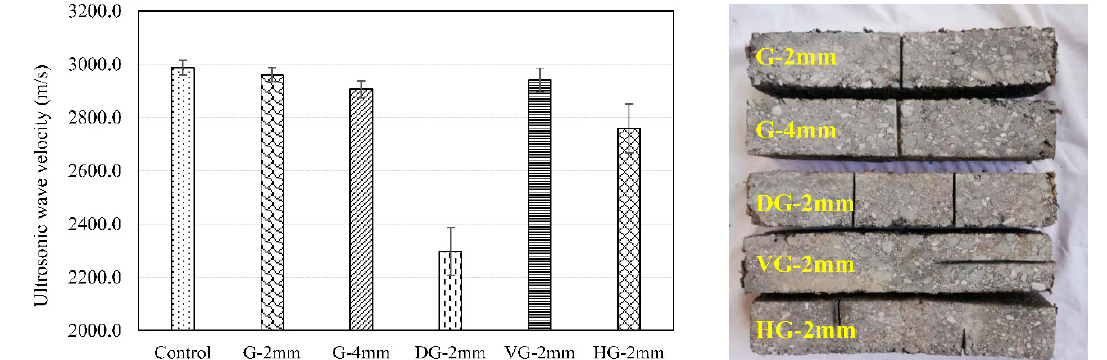
Figure 5. The velocity of ultrasonic waves with five types of grooves.